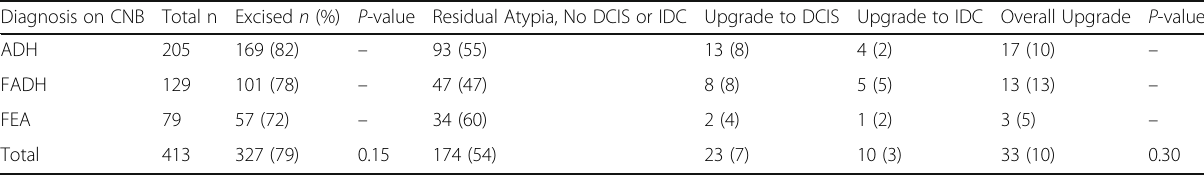
Table 1 Excision, upgrade and residual atypia rates by diagnostic